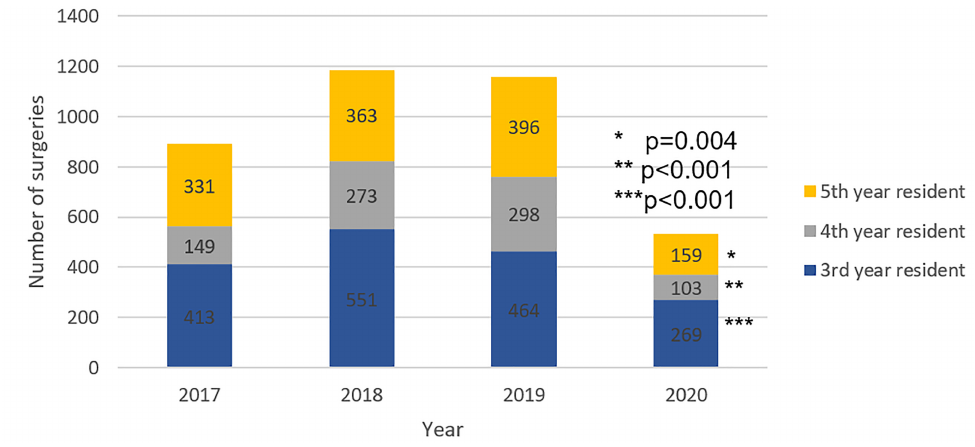
Figure 3 - Comparison of surgical volume categorized by year of urology residency from February 27th to May 30 th